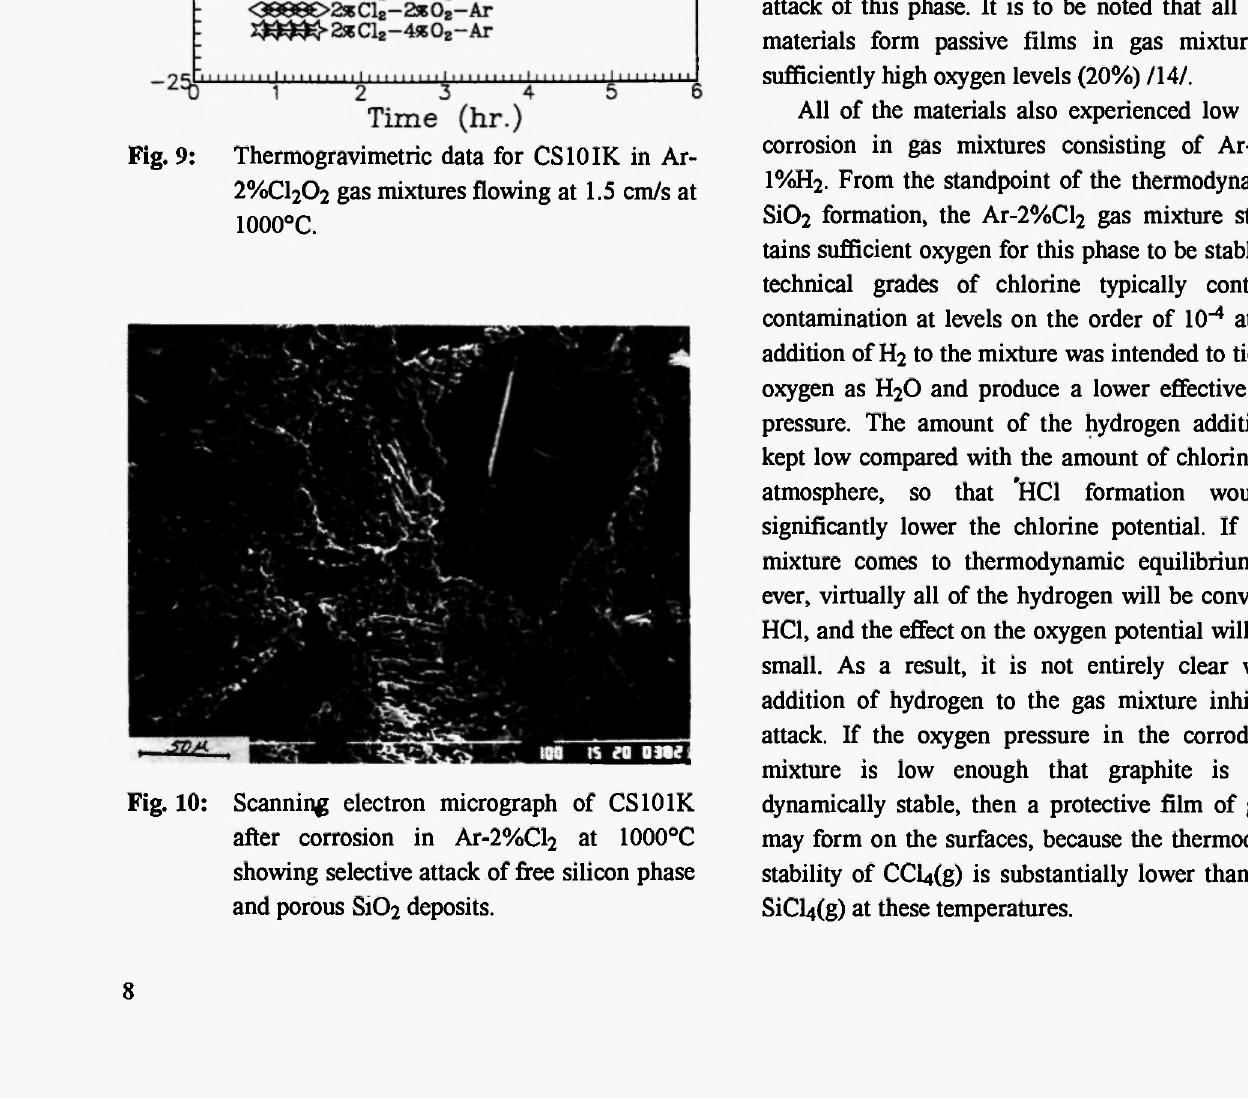
Fig. 10: Scanning electron micrograph of CS101K after corrosion in Ar-2%C1 showing selective attack of free silicon phase and porous S1O2